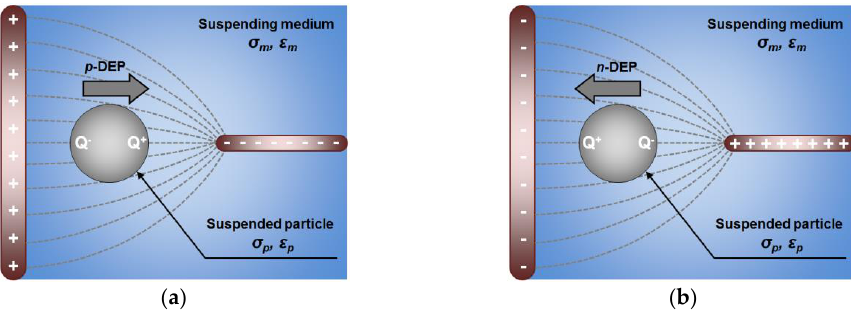
Figure 1. Dielectrophoretic (DEP) motion of a dielectric particle in a non-uniform electric field. ( a ) Positive dielectrophoresis, in which a dielectric particle moves toward a strong electric field region. ( b ) Negative dielectrophoresis, in which a dielectric particle migrates to a weak electric field region. Reproduced from [40], with the permission of AIP Publishing (2012).